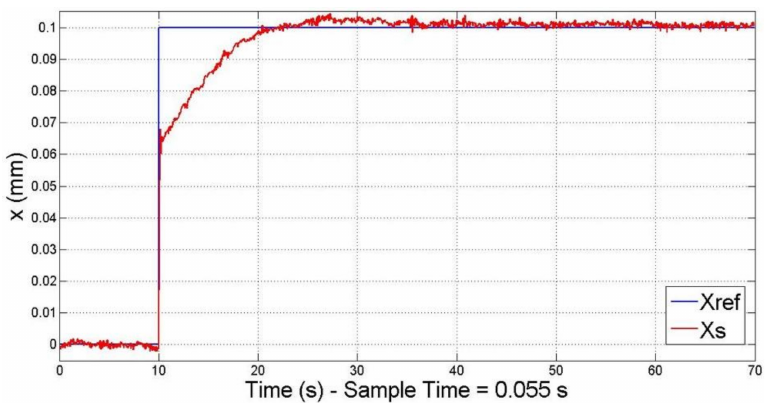
Figure 9. Experimental result: Response to 100 µ m